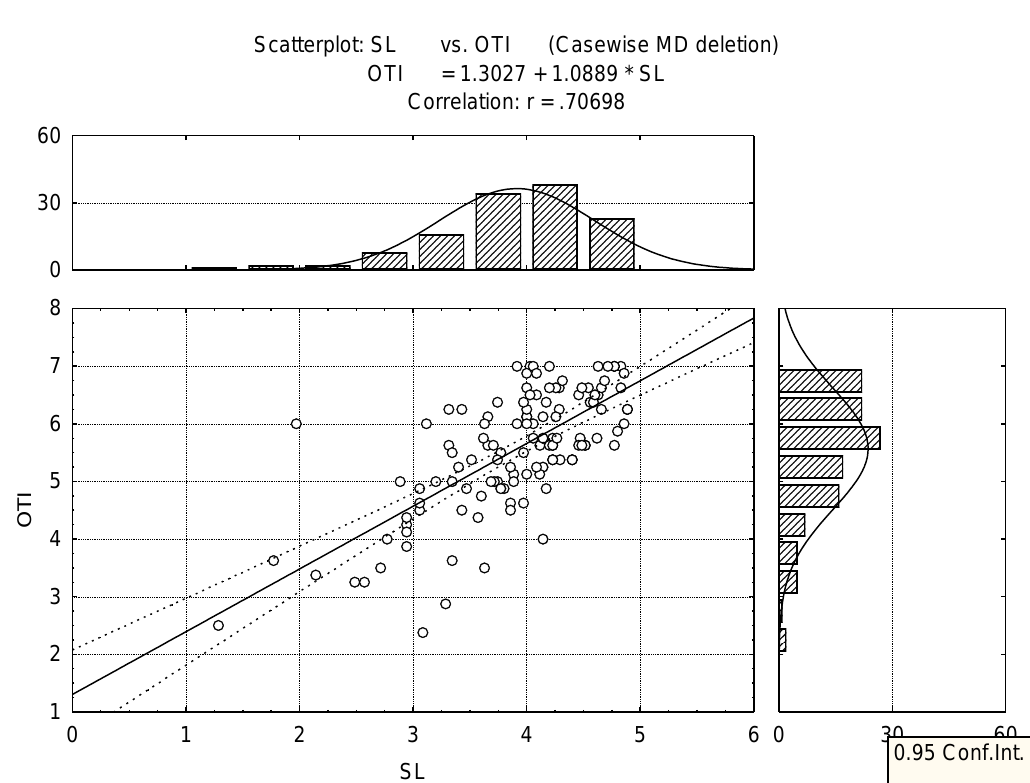
Figure 1: Statistica scatterplot and calculated Pearson’s-r for correlation between servant leadership mean scores and interpersonal trust mean